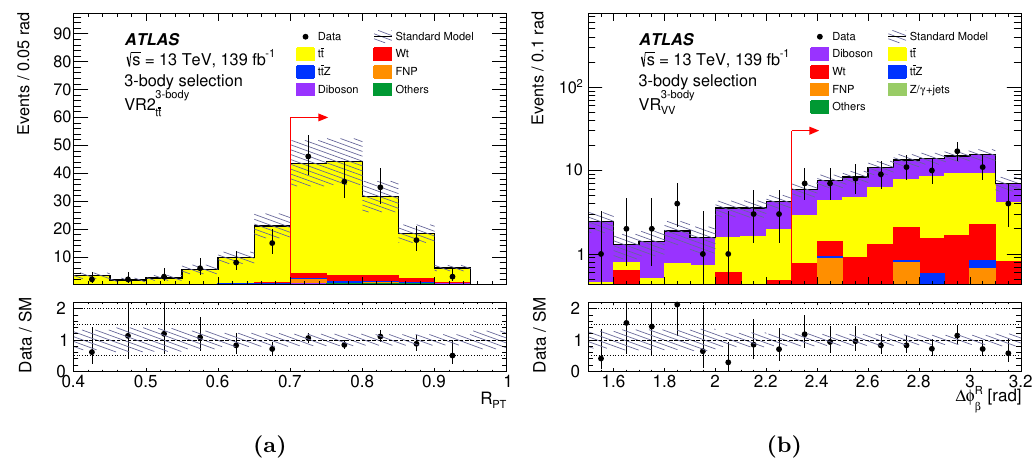
Figure 5 . Three-body selection. Distributions of (a) R in the validation region VR(2) 3-body and p T tt (b) ∆ φ R in the validation region VR 3-body , after the background fit. The contributions from all SM β V V backgrounds are shown as a histogram stack. “Others” includes contributions from V V V , tt t , tttt , tt W , tt WW , tt WZ , tt H , and tZ processes. The hatched bands represent the total statistical and detector-related systematic uncertainty. The bottom panels show the ratio of the observed data to the total SM background prediction, with hatched bands representing the total uncertainty in the background